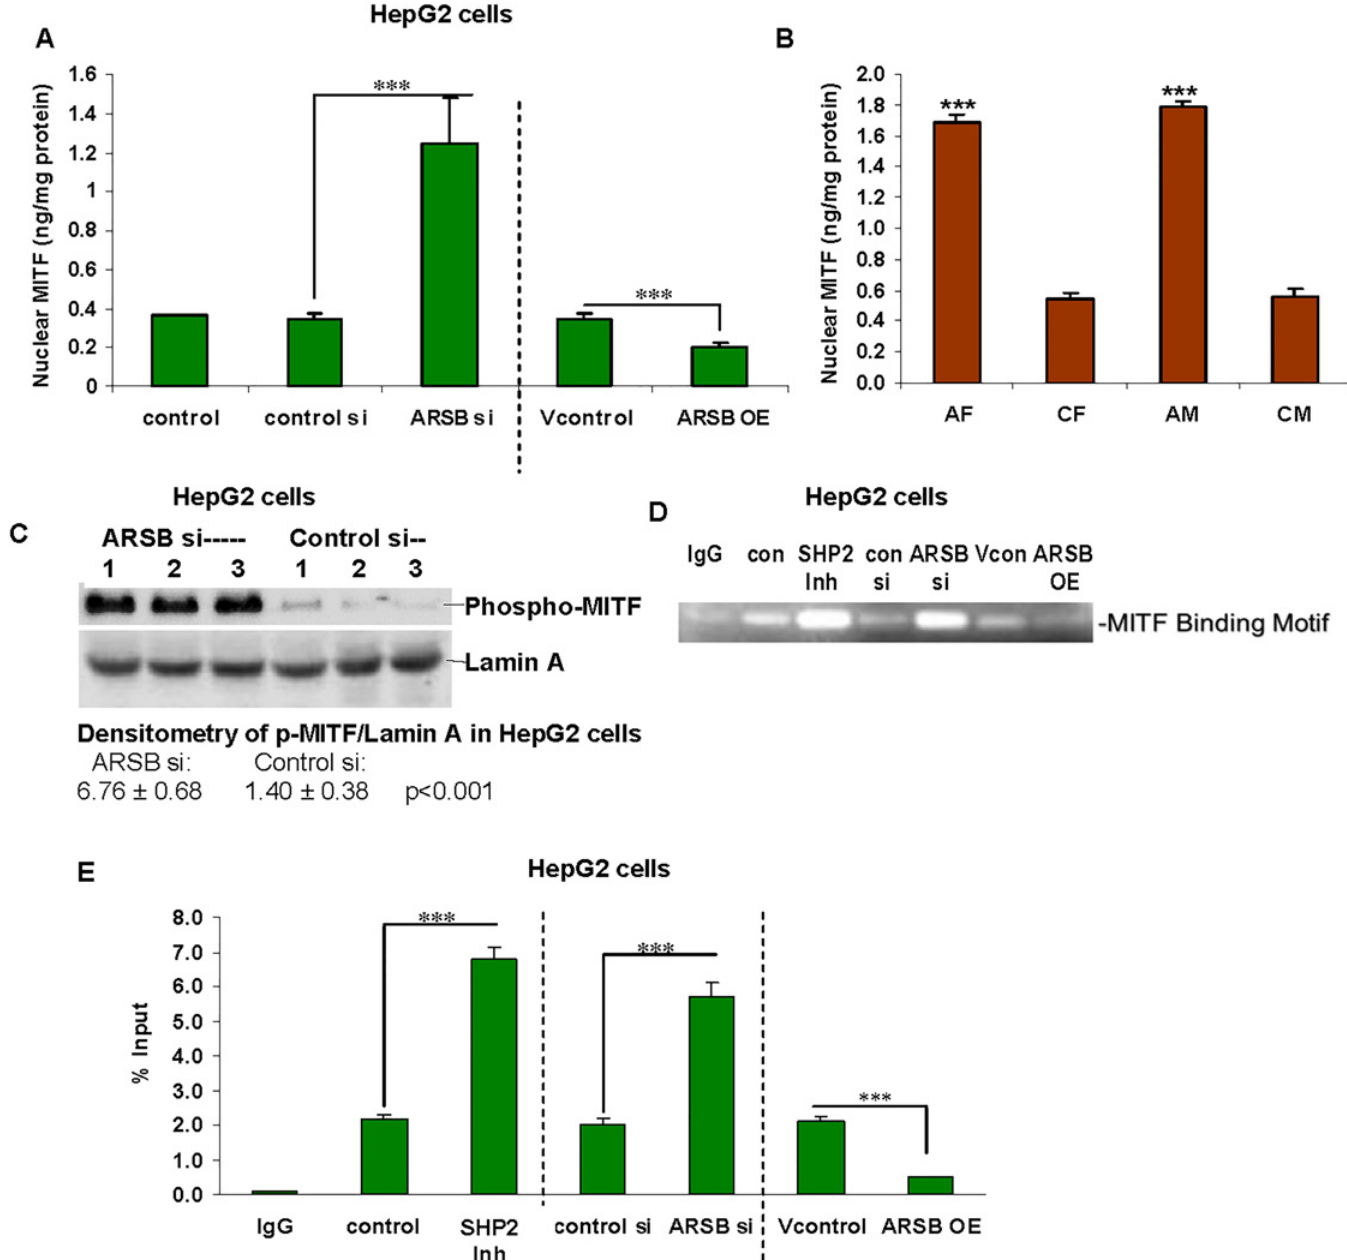
Fig 2. Nuclear MITF and activation of GPNMB promoter follow decline in ARSB. (A) Nuclear MITF increased from 0.36 ± 0.001 ng/mg protein to 1.22 ± 0.11 ng/mg protein following ARSB silencing (p < 0.001,n = 6). Nuclear MITF declined to 0.20 ± 0.02 ng/mg protein when ARSB was overexpressed (p = 0.003, unpaired t-test, two-tailed; n = 3). (B) In the hepatic tissue of the ARSB-null female and male mice, nuclear MITF increased to ~3 times the level in the normal age- and gender-matched C57BL/6J mice (p < 0.001, n = 12). (C) Western blot shows marked increase in density of the bands for nuclear phospho-MITF in the HepG2 cell following ARSB silencing. The nuclear envelope protein Lamin A was used as control. Densitometry showed that intensity increased to ~4.8 times the control level. (D) Chromatin immunoprecipitation assay demonstrated increased binding to the MITF motif in the GPNMB promoter following ARSB silencing and reduced binding following ARSB overexpression in the HepG2 cells (n = 6). Treatment of the cells with the SHP2 inhibitor (PHSP1) also increased the binding to the MITF motif. (E) Densitometry of the MITF binding to the GPNMB promoter increased following ARSB knockdown or treatment with the SHP2 inhibitor PHSP1. Following ARSB overexpression, MITF binding declined significantly. [AF = ARSB-null female; AM = ARSB-null male; ARSB = arylsulfatase B; CF = control female; ChIP = chromatin immunoprecipitation; CM = control male; con = control; GPNMB = glycoprotein (transmembrane) NMB; Inh = inhibitor; MITF = microphthalmia-associated transcription factor; N.D. = no difference; OE = overexpression; SHP2 Inh = PHSP1 = SHP2 inhibitor; si = siRNA; Vcon = vector control]